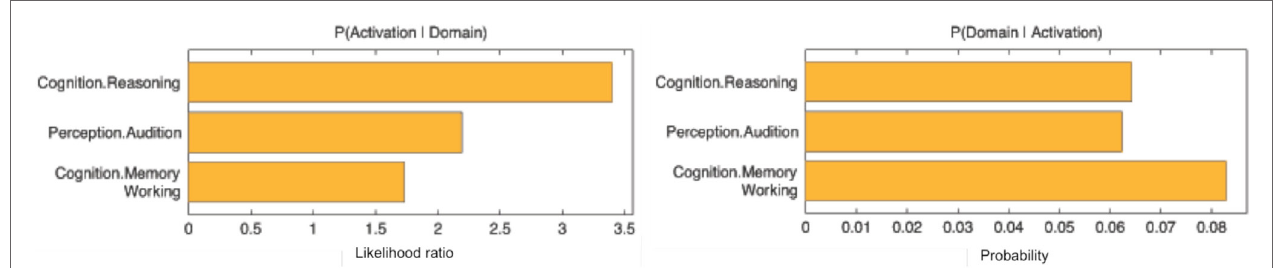
FigUre 3 | Behavioral domains from the BrainMap database significantly associated with the seed, p < 0.05